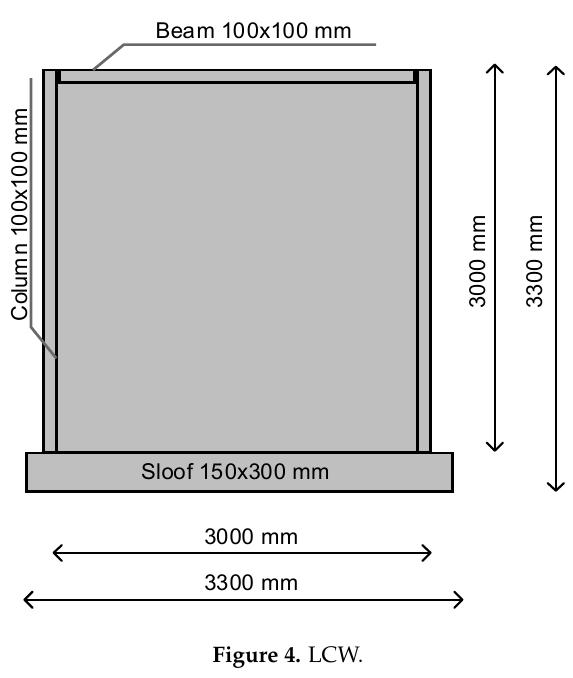
Table 1. Dimension of the specimen of no-fine lightweight concrete wall.